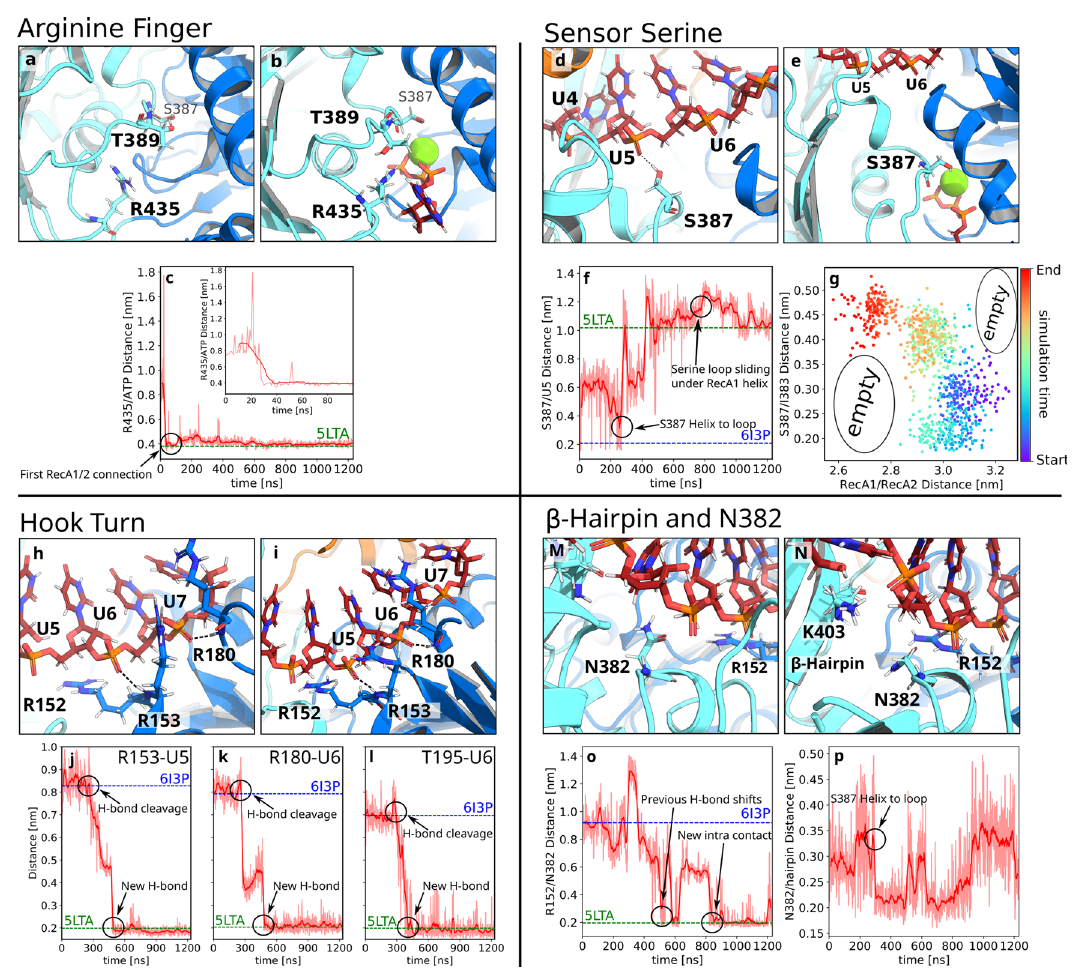
Fig. 5 Molecular switches of the closing process. Conformational transitions of ( a – c ) the arginine fi nger, ( d – g ) sensor serine, ( h – l ) RecA1 – RNA interactions, and ( m – p ) β -hairpin during Prp43 closing. a , d , h , m Molecular switches in the initial and ( b , e , i , n ) fi nal frames of adaptive sampling of the closing process. c , f , j – l , o , p In the distance plots, the time averages are drawn as dark red lines while the underlying data of each frame is drawn in pale red. Critical atomic distances that quantify the progression of the closing transition. Dashed lines indicate the distances in the 5LTA and 6I3P crystal structures. a Open RecA1/RecA2 interface with distant R435 and T389 residues. b Closed conformation with ATP in the binding pocket (stick representation), thereby bridging the closed RecA1/RecA2 interface. R435 is tightly bound to the phosphate groups of ATP. c R435/C ζ – ATP/O3B distance, revealing an R435 – ATP H-bond formation early during the closing process. d Open conformation with the sensor serine S387 in the helical state and forming an H-bond with U5 of the RNA. e Closed conformation with S387 in the loop conformation, bound to the ATP – Mg 2 + complex, and reaching underneath the RecA1 R152 – L167 helix. f R435 – U5 distance during the closing process. g S387 – I383 distance versus RecA1 – RecA2 distance. The color indicates the cumulative simulation time. h Open conformation with R153 and R180 of RecA2 hydrogen bound to U6 and U7, respectively. i Closed conformation with R153 and R180 hydrogen bound to U5 and U6, respectively, shifted one nucleotide upstream relative to the open